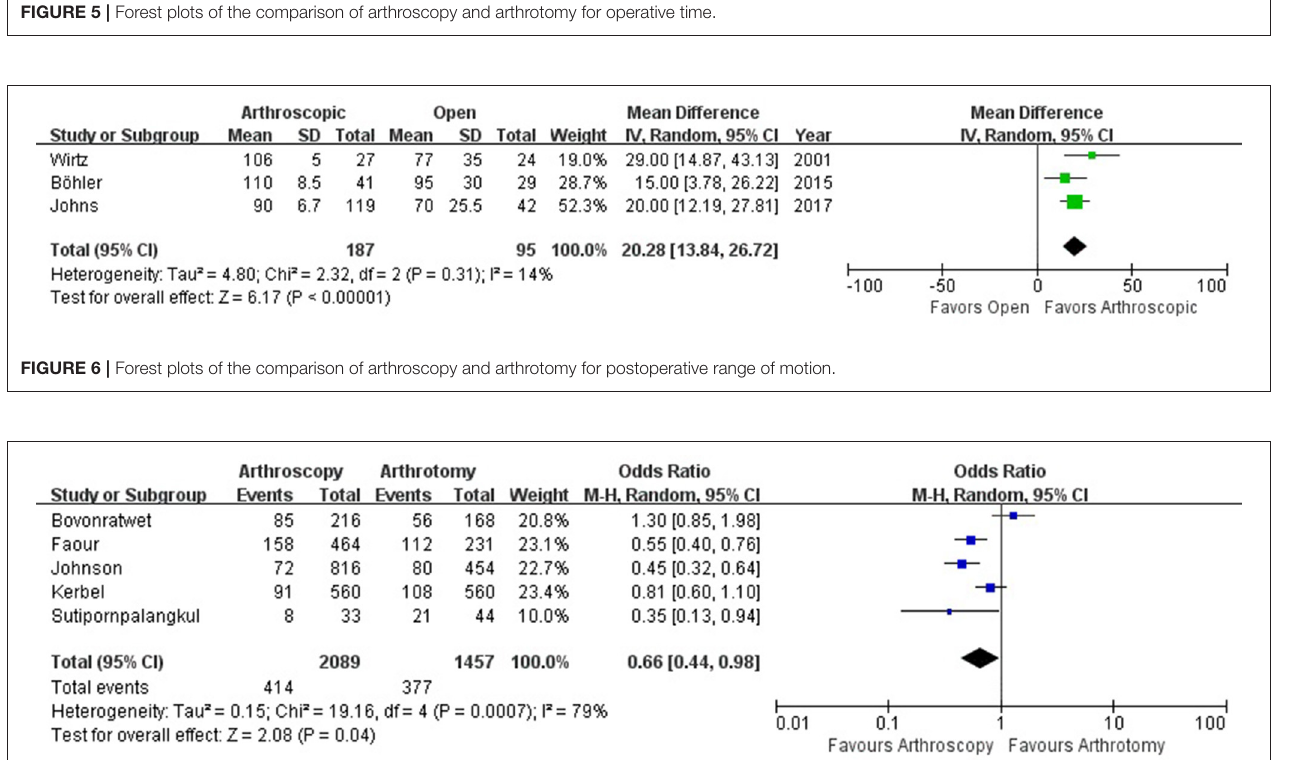
FIGURE 5 | Forest plots of the comparison of arthroscopy and arthrotomy for operative time.